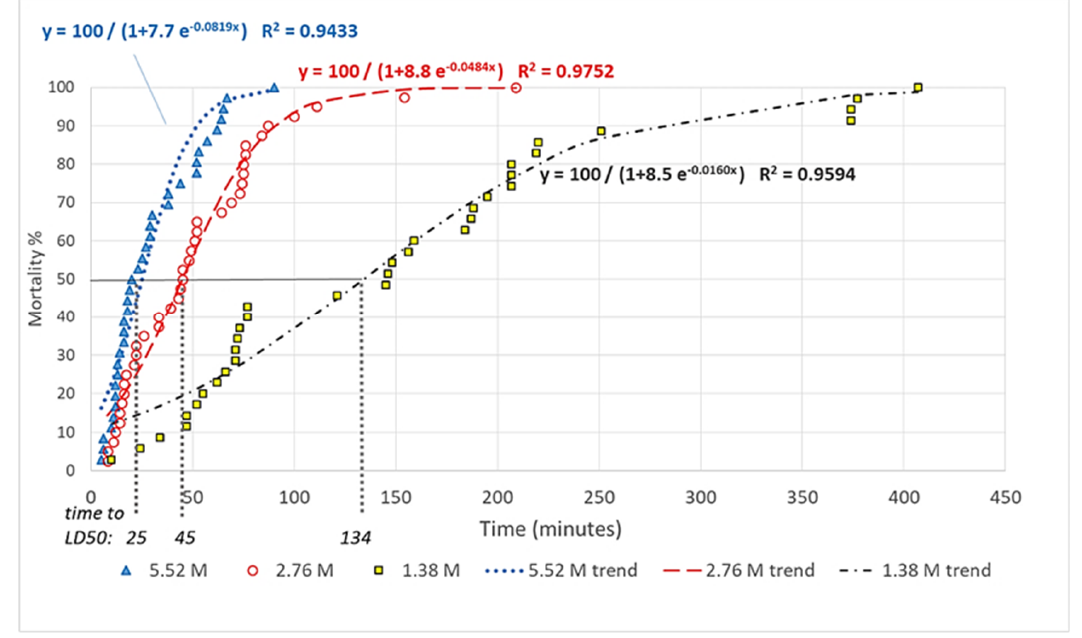
Figure 2. Abbott corrected mortality rates and fitted trends for the three LiCl-concentrations. Table 3. Time to the death of 50% (LT50) and 90% (LT90) of animals (in minutes).